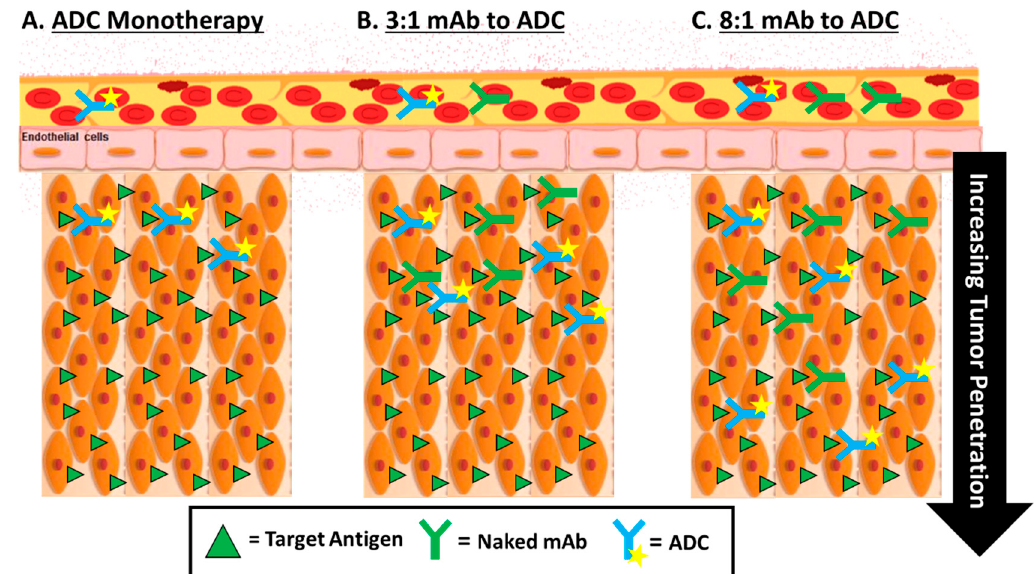
Figure 6. Improving the tumor penetration of ADCs in solid tumors through co-administration of matching non-conjugated (‘naked’) antibody therapy. ( A ) The administration of ADCs as a monotherapy may result in only perivascular distribution into the tumor due to rapid biding of target antigens just outside of the vasculature. ( B , C ) In theory, this binding site barrier can be overcome by providing ‘naked’ mAb therapy to compete for target antigen sites—resulting in ADCs to travel further into the tumor to find available antigen to bind. However, administration of the combination of ADC and naked mAb may also inhibit the clearance of the ADC by the IIS/MPS. Thus, the increased delivery of the ADC in combination with mAb may be due an overall higher systemic/serum exposure resulting in the potential for increased delivery into the tumor. The effects of co-administration of ADCs and mAb on saturation of clearance via the MPS needs to be evaluated for each combination regimen.